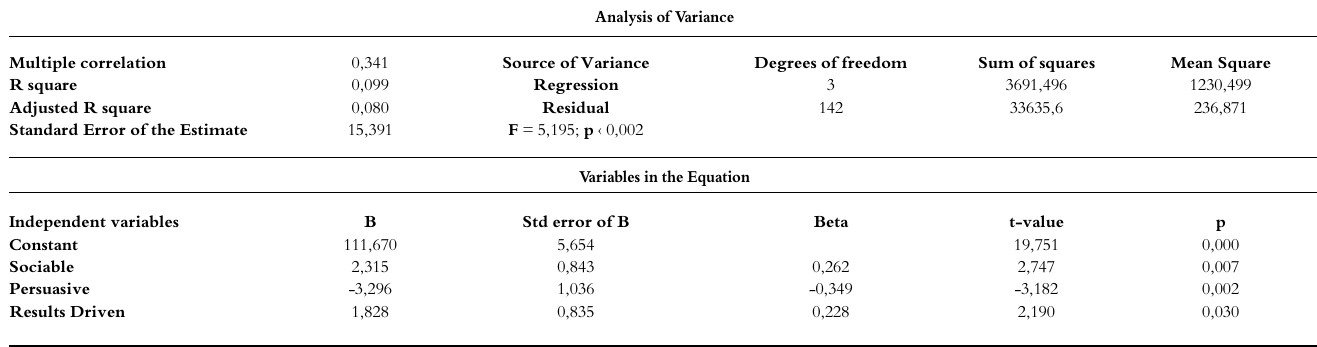
TABLE 6 Analysis of Variance